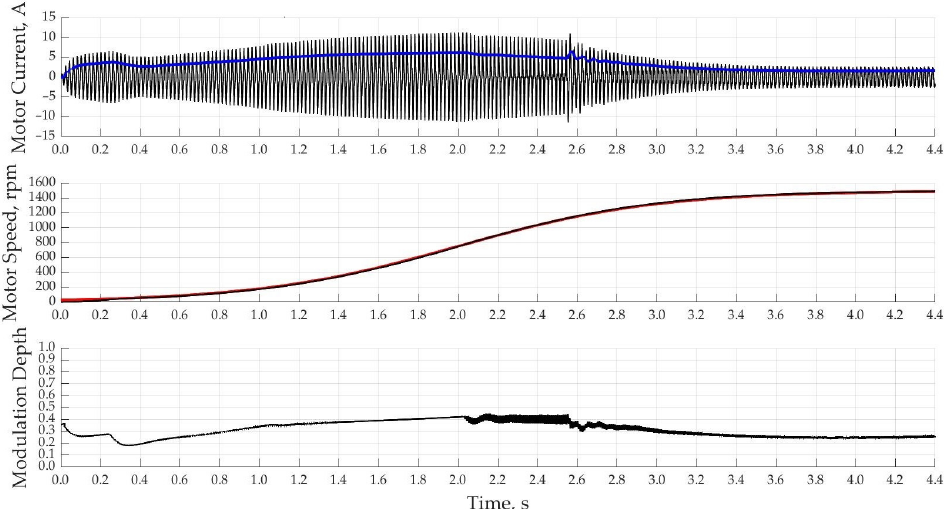
Figure 17. Starting current, motor speed and modulation depth for case of PI-controller with double- loop CS of current and speed of IM with sigmoidal increase in speed by reference.